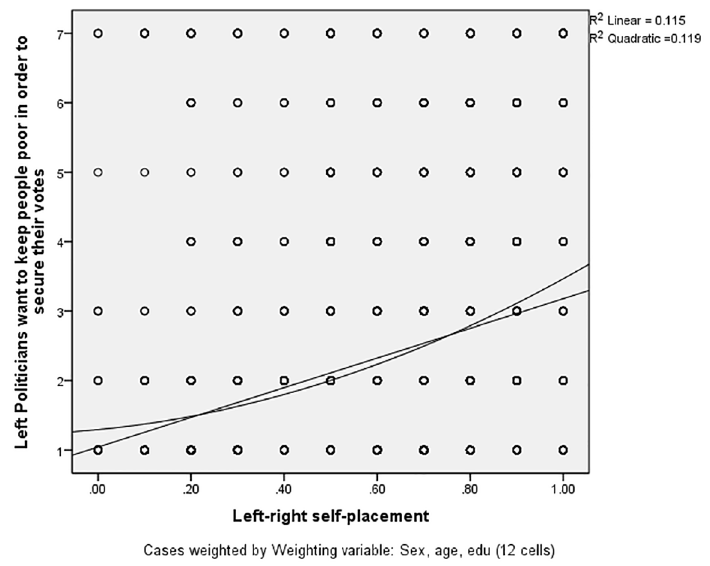
Figure 6. Linear and quadratic relationship between political ideology and belief that left politicians want to keep people poor.